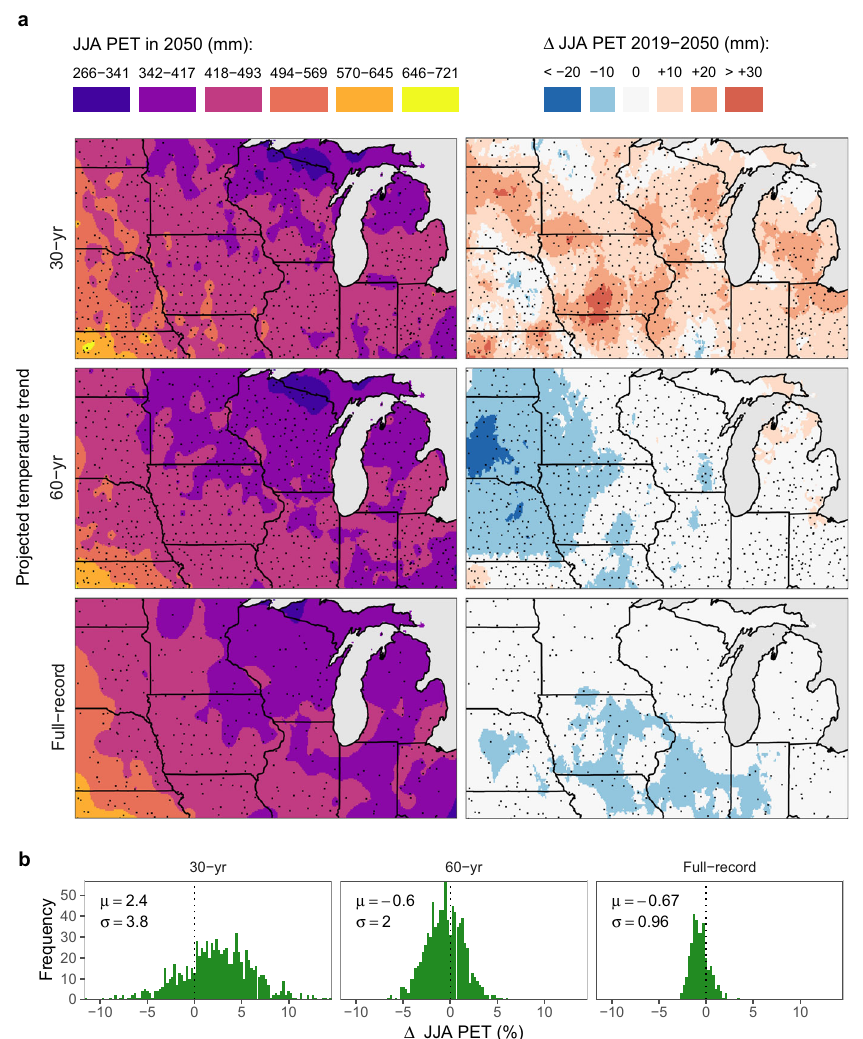
Fig. 4 Potential evapotranspiration (PET) based on temperature trends for 30-year, 60-year, and full-record times series projected into 2050. a Spatial patterns of projected PET and their absolute change compared to current climate. Points indicate locations of the weather stations. b Histograms depict the distribution of the projected PET (as relative percent change) across all weather